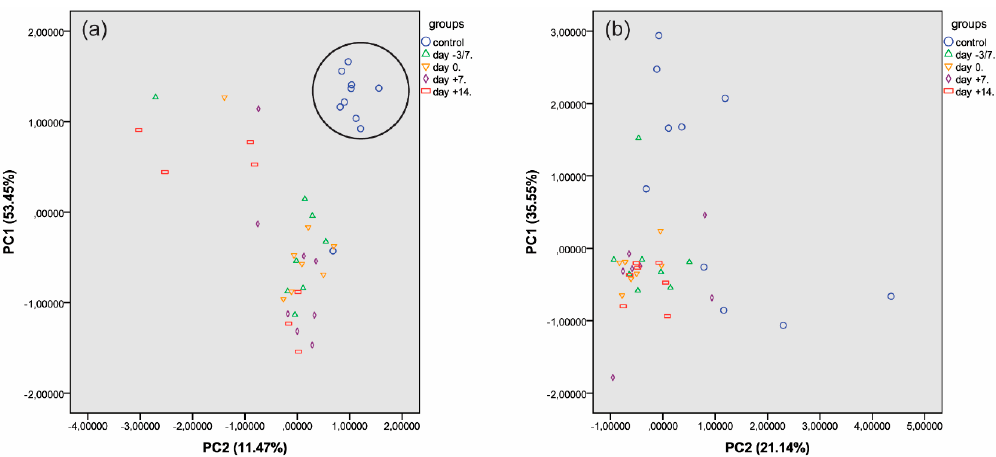
Figure 4. Principal component analysis of serum ( a ) and salivary ( b ) IgA N ‐ glycosylation datasets in controls and at four different stages of APSCT (for key to symbols see upper right